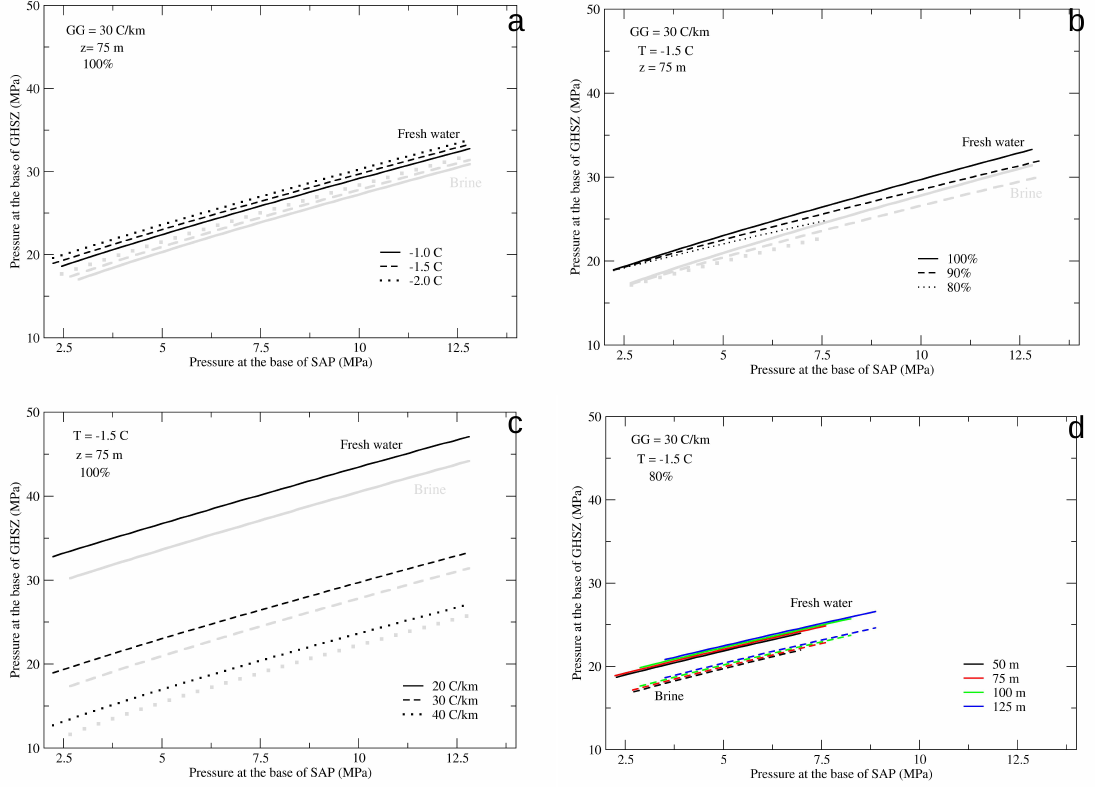
Figure 2. P GHSZ versus P SAP for freshwater and brine cases. In each panel, one parameter is changed, while the others are